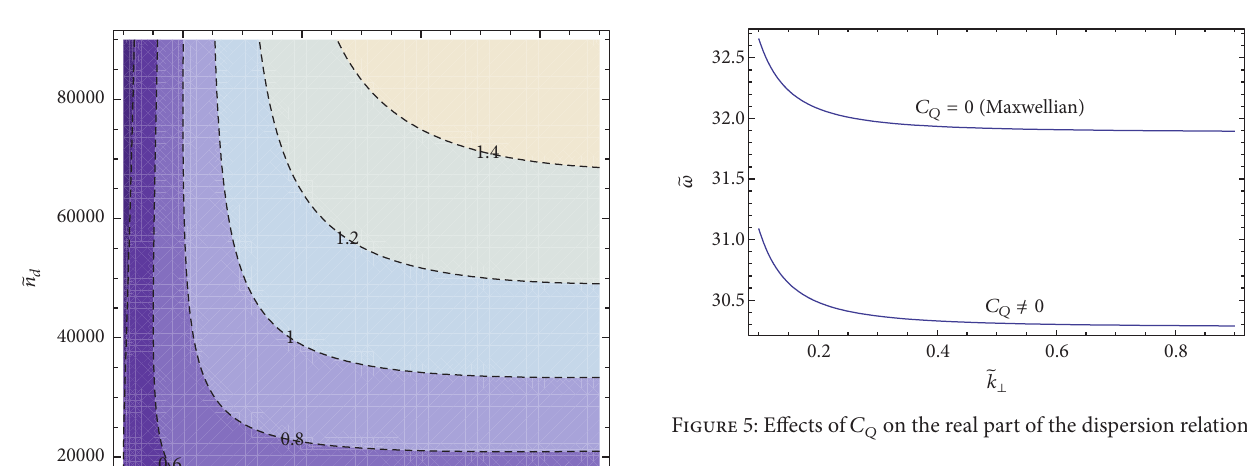
Figure 3: Plots between